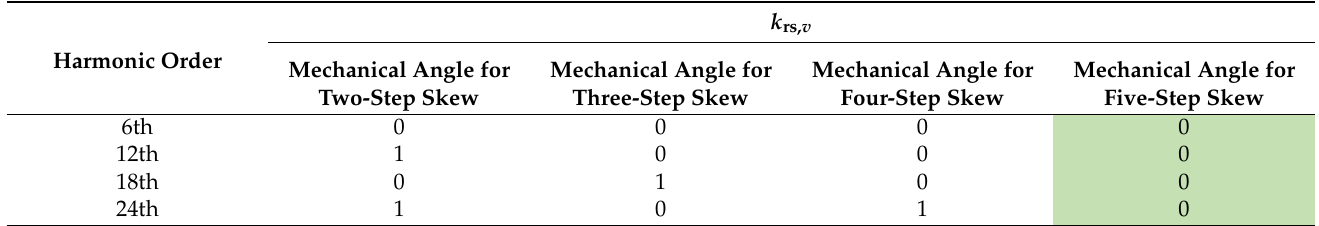
Table 11. Value of the mitigation factor when the sixth harmonic component is selected to reduce ( w = 6 ) .